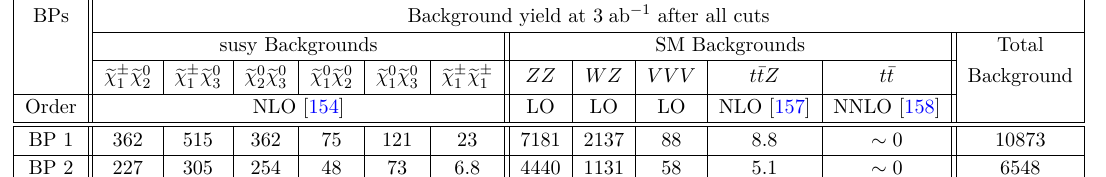
Table 5. The cut-flow table for the benchmark point 1 in the b-veto category of ‘‘ + /E with 5F signal production and dominant backgrounds.